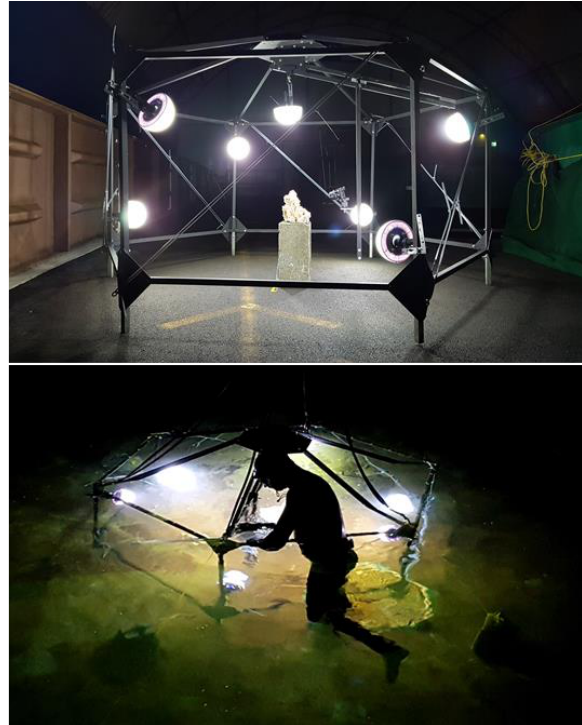
Figure 4. The quality of SfM data sets, derived from photographs collected in a dryland (top) and wet-lab (bottom) environment, was evaluated to quantify the impact of a dark, cold water marine environment.